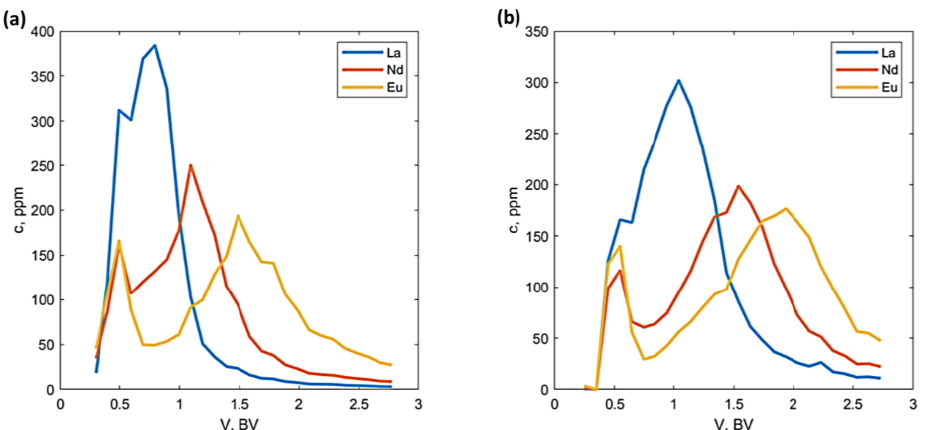
Figure 4. Separation of REEs on IRA-410 using ( a ) HNO 3 and ( b ) HCl as the eluent (T = 298 ± 2K; flowrate = 2.98 BV/h; feed volume = 0.025 BV; acid concentration = 10 mM).